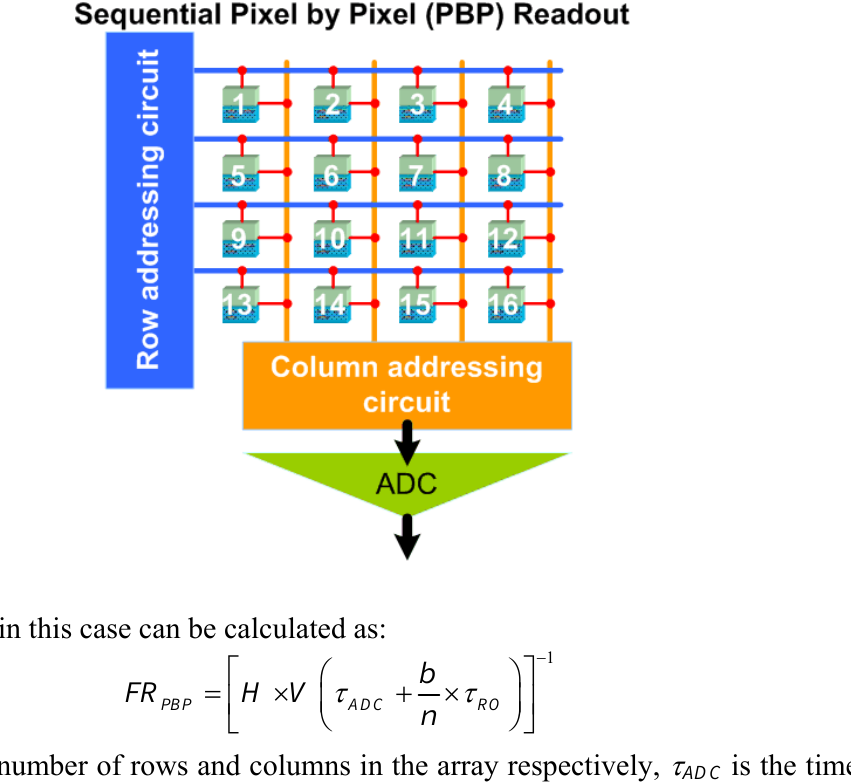
Figure 3. Array access in a simple pixel-by-pixel (PBP) sequential readout